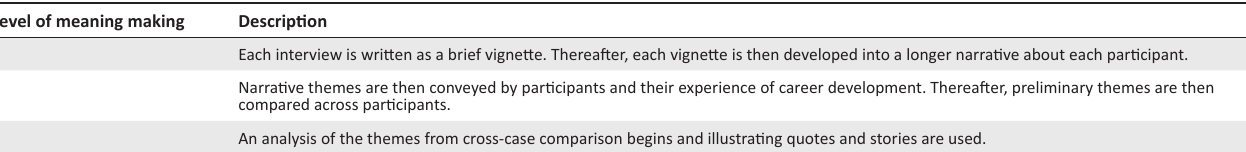
TABLE 3: Data analysis